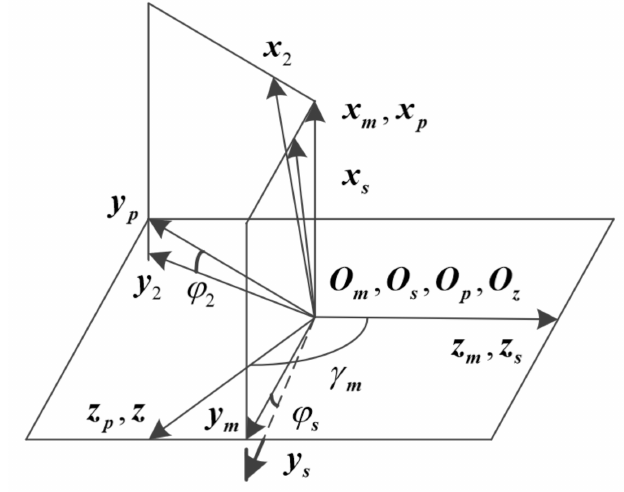
Figure 3. The coordinate systems of shaper machining face